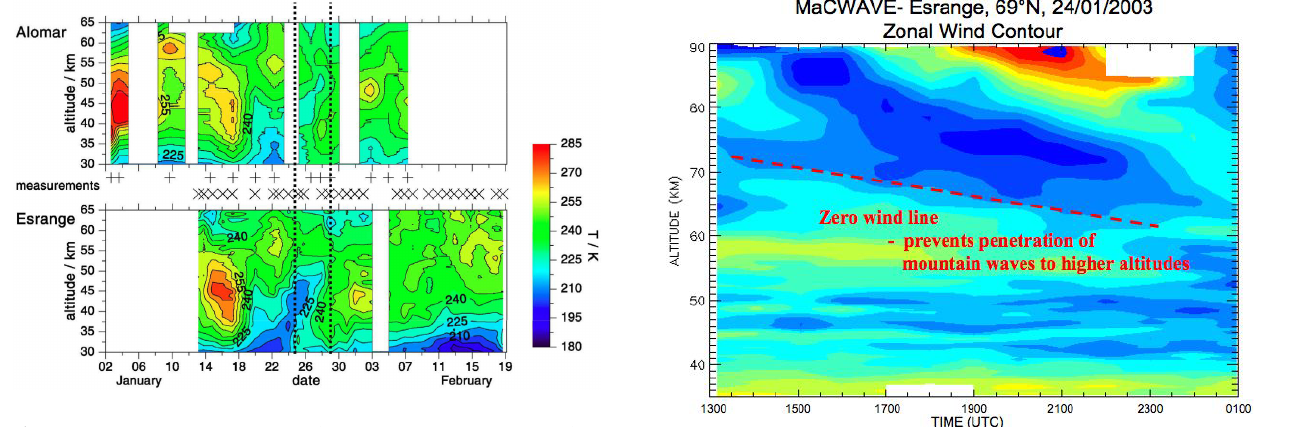
Fig. 11. RMR lidar soundings of temperature up to 65km from ALOMAR and Esrange during the MaCWAVE winter period (after Blum et al., 2006). Measurement dates for the Alomar RMR lidar are marked with + signs, those of the Esrange RMR lidar with X signs. Both lidars show the onset of a stratospheric warming on about 15 January 2003.